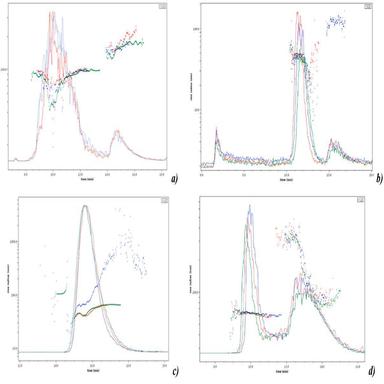
AF4-FFF-MALS fractograms of PPPs of three different injections: a) CS; b) EC; c) OD; d) WP.